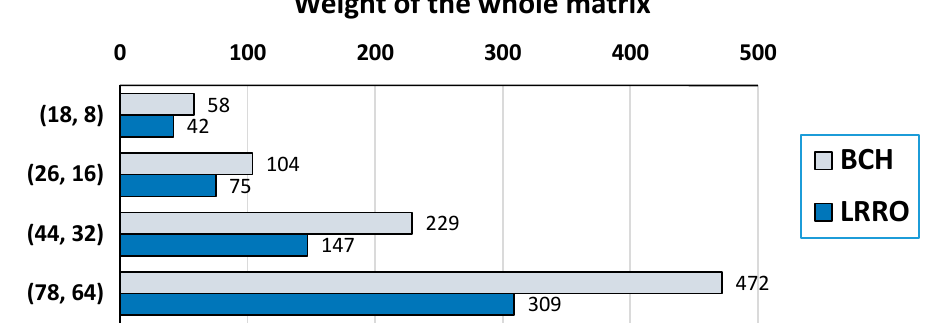
Figure 4. Hamming weights of the whole matrix.